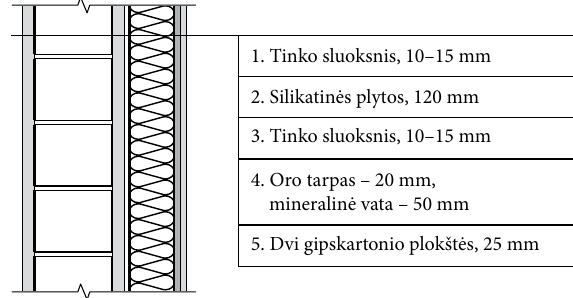
Fig. 3. Wall construction from silicate